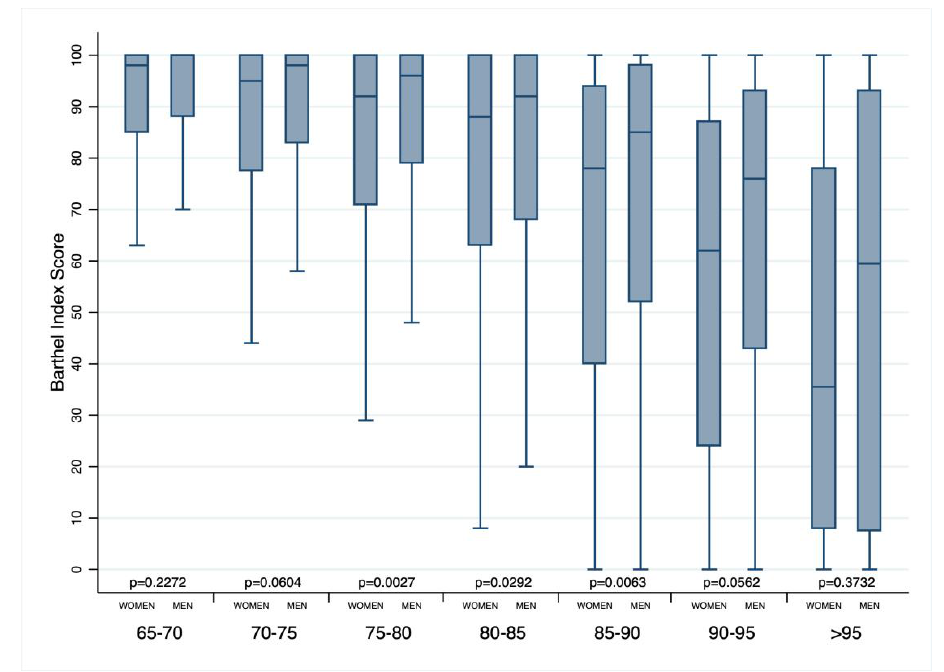
Figure 2. Box-whisker plot of the Barthel index according to sex and age classes. Men had a higher in-hospital, 3-month, and 1-year mortalities and comorbidity and severity index. In the 70 – 90 year age groups, men had a severity index significantly higher than women (Figure 3).